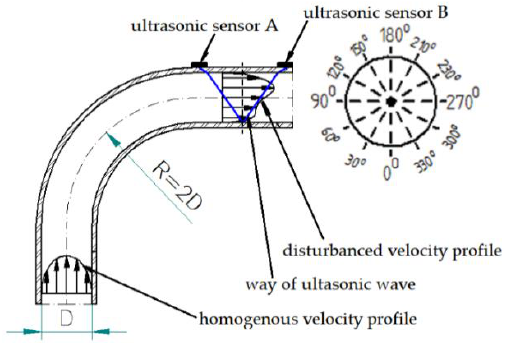
Figure 3. Diagram of the measurement area.